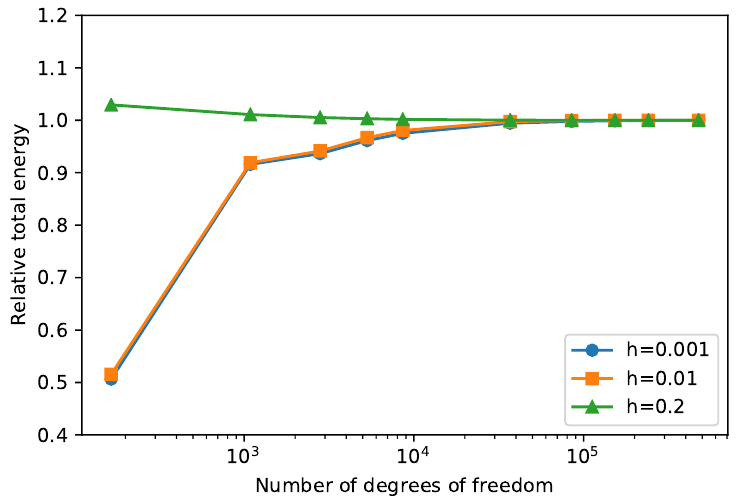
Figure 6. Total energy convergence for the quadratic mixed approach ( p = 2) for different thicknesses.